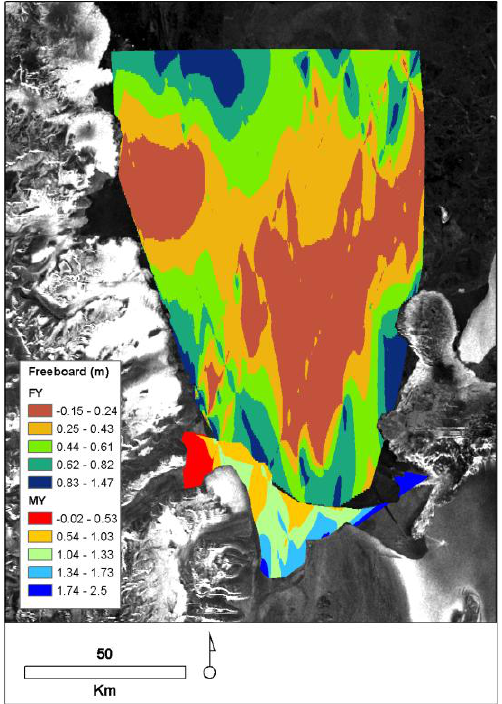
Table 1. Freeboard statistics of the study area for each year.